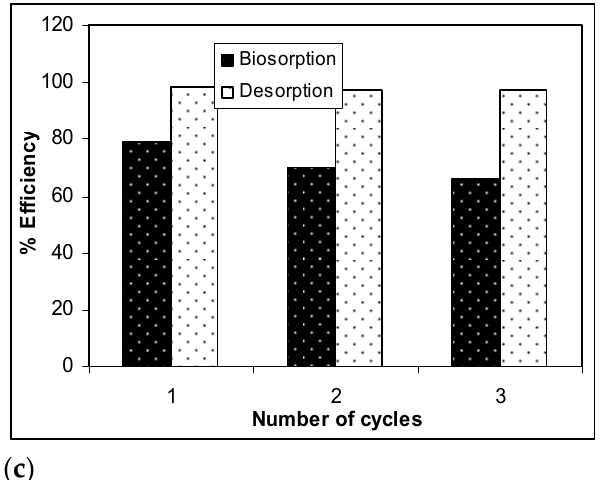
Figure 7. Biosorption/desorption efficiency of heavy metal ions on Na-SW biomass during the three cycles: ( a ) Pb(II); ( b ) Cd(II); ( c ) Zn(II).